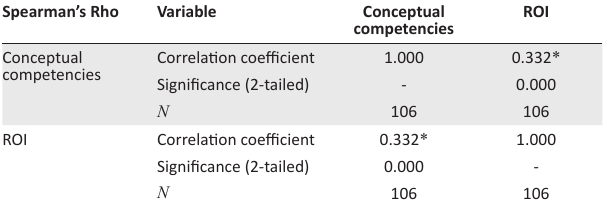
TABLE 6 : Spearman’s correlation on managerial conceptual competencies versus return on investment. Spearman’s